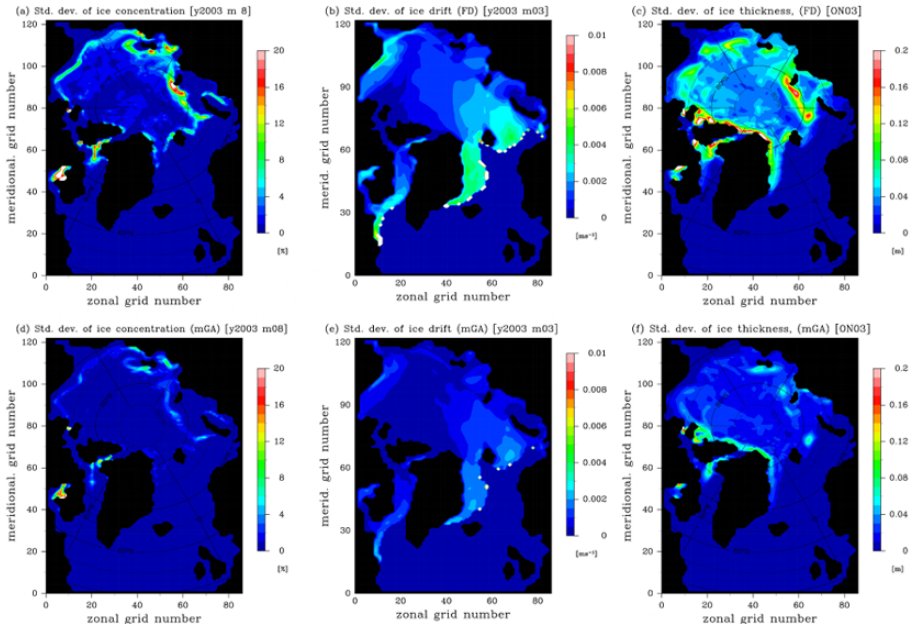
Fig. 10. Standard deviation of the simulated sea ice fields calculated from the 10 model runs. In the respective model runs, the optimized parameter sets obtained from the 10 independent optimization experiments by the finite difference method using the standard-code (the model runs in a–c ), or those by the µGA – 1 (the model runs in d–f ) were applied. The standard deviations of ( a and d ) monthly mean sea ice concentration in August 2003, ( b and e ) monthly mean ice drift velocity in March 2003 and ( c and f ) ice thickness in ON03 ICESat campaign